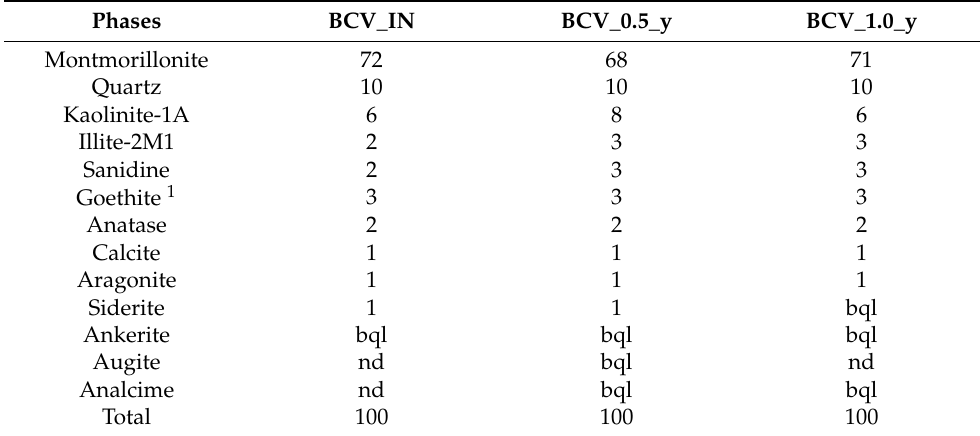
Table 1. Semiquantitative XRD analysis of randomly oriented powder mounts (wt.%); bql—below quantification limit, nd—not